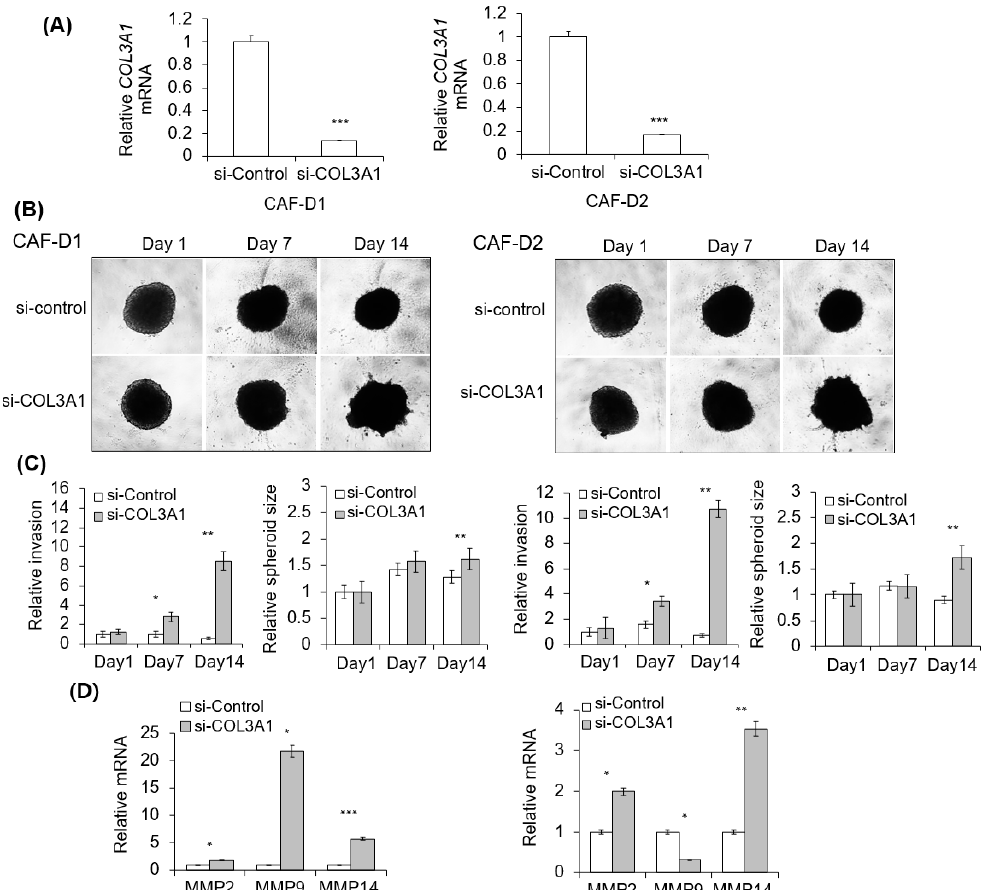
Figure 7. Effect of collagen knockdown-CAF-D on FaDu spheroid invasion. ( A ) CAF-D cells were transfected with siCOL3A1 for two days, and CM was collected. siRNA efficiency was evaluated using qPCR analysis. ( B ) FaDu spheroid (400 μ m in diameter) was formed by culturing a 96-well U-bottom Ultra-Low Attachment plate for two days. CM and Matrigel were added to each well, and the spheroid invasion was monitored for 14 days using phase-contrast microscopy (5× magnification). ( C ) Cell invasion was quantified by measuring the mean number of tube-like structures extending from the surface of each spheroid. The spheroid size was quantified using Cell 3 iMager. ( D ) MMPs mRNA expression in FaDu spheroids were analyzed using qPCR on day 14. Results represent the mean ± standard deviation of three experiments (* p < 0.05, ** p < 0.01, *** p < 0.005).